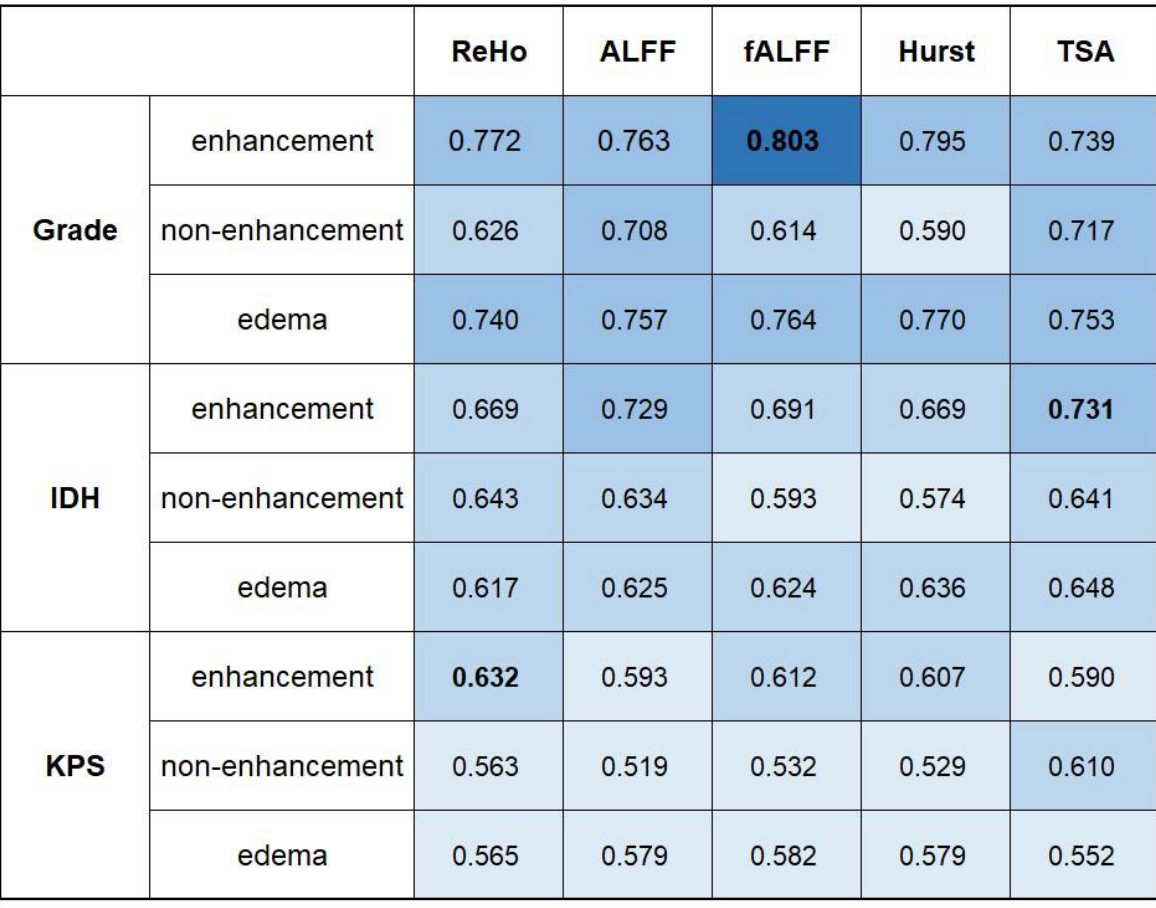
Figure 3. Heatmap depicting the differentiating power of conventional rs-fMRI parameters (rows) with the AUROC based on the three ROIs (columns) in the grading model, IDH model and survival model.